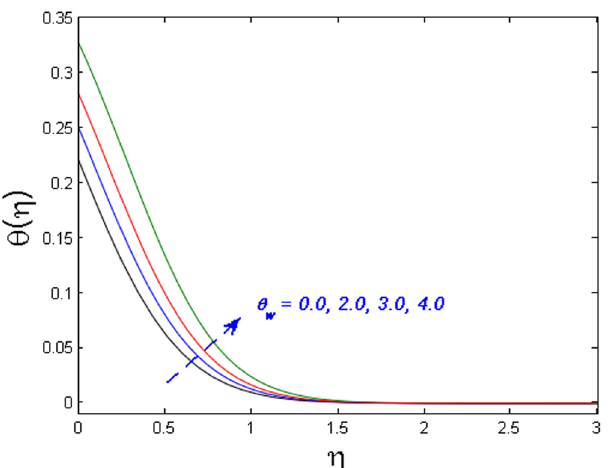
Figure 19. Effect θ w on θ ( η ).